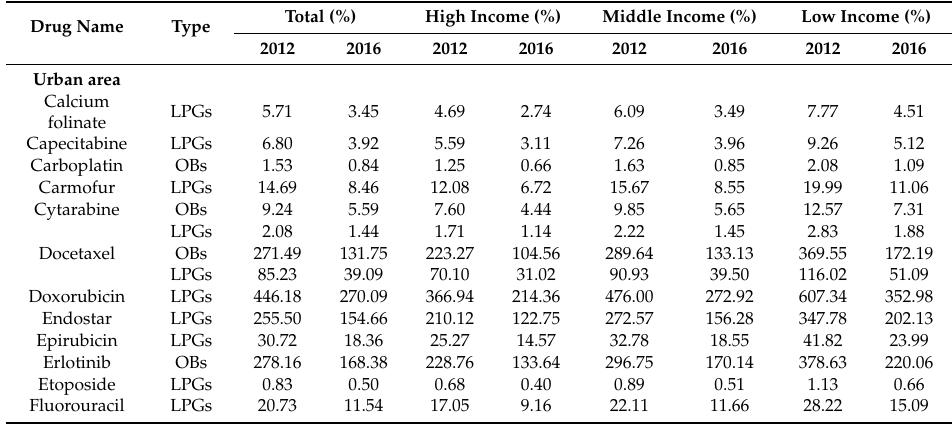
Table 7. A ff ordability of anticancer medicines in the urban and rural areas in di ff erent regions of the Jiangsu